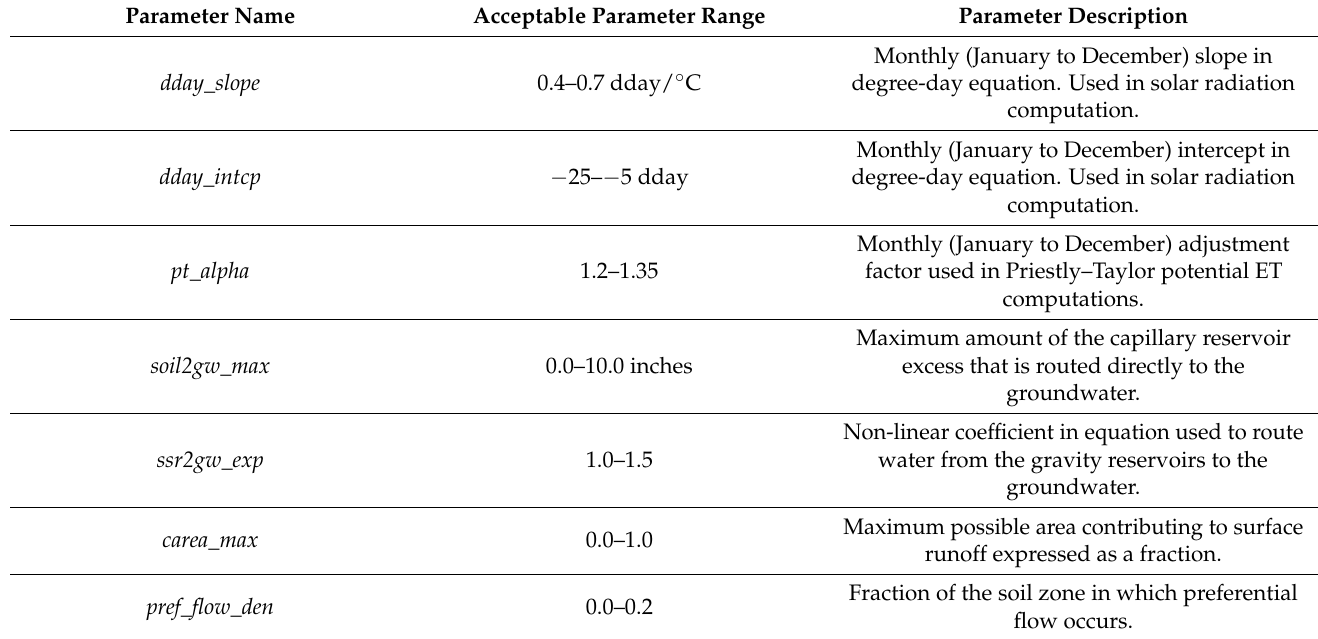
Table 4. Parameters of the Precipitation-Runoff Modeling System that were automatically calibrated using the Let-Us-Calibrate (Luca)